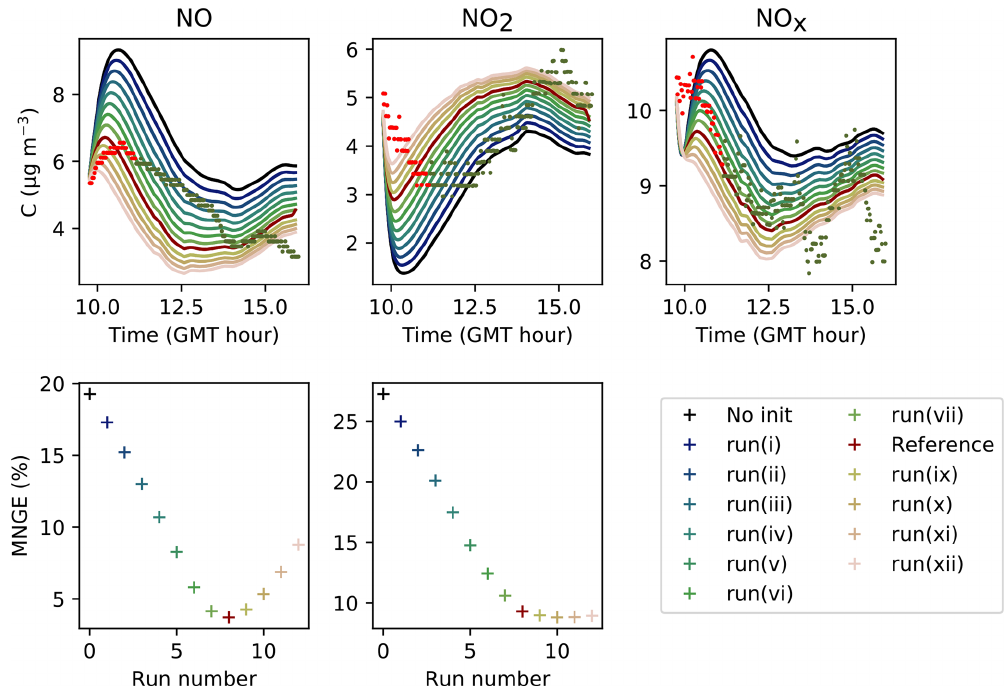
Figure B2. Concentration initialization for Experiment 2: for this experiment, proper initial concentrations are considered to be achieved when the MNGE with respect to NO reaches a minimum, while the MNGE of NO 2 reaches stabilization.